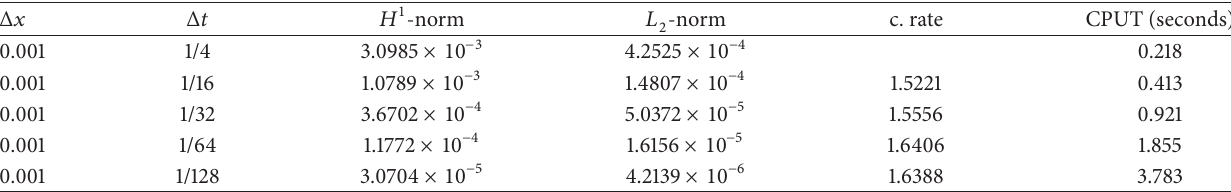
Table 3: Convergence rate in time for (46) with 𝛼 = 0.5 and 𝛽 = 0.25 .